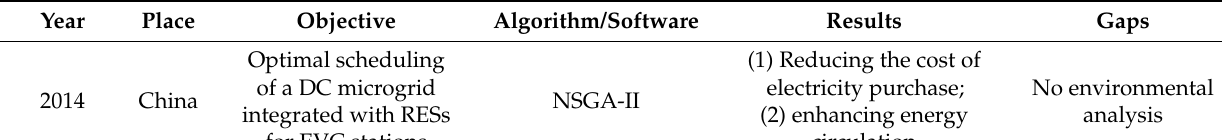
Table 1. Summary of previous approaches dedicated to EV charging research.